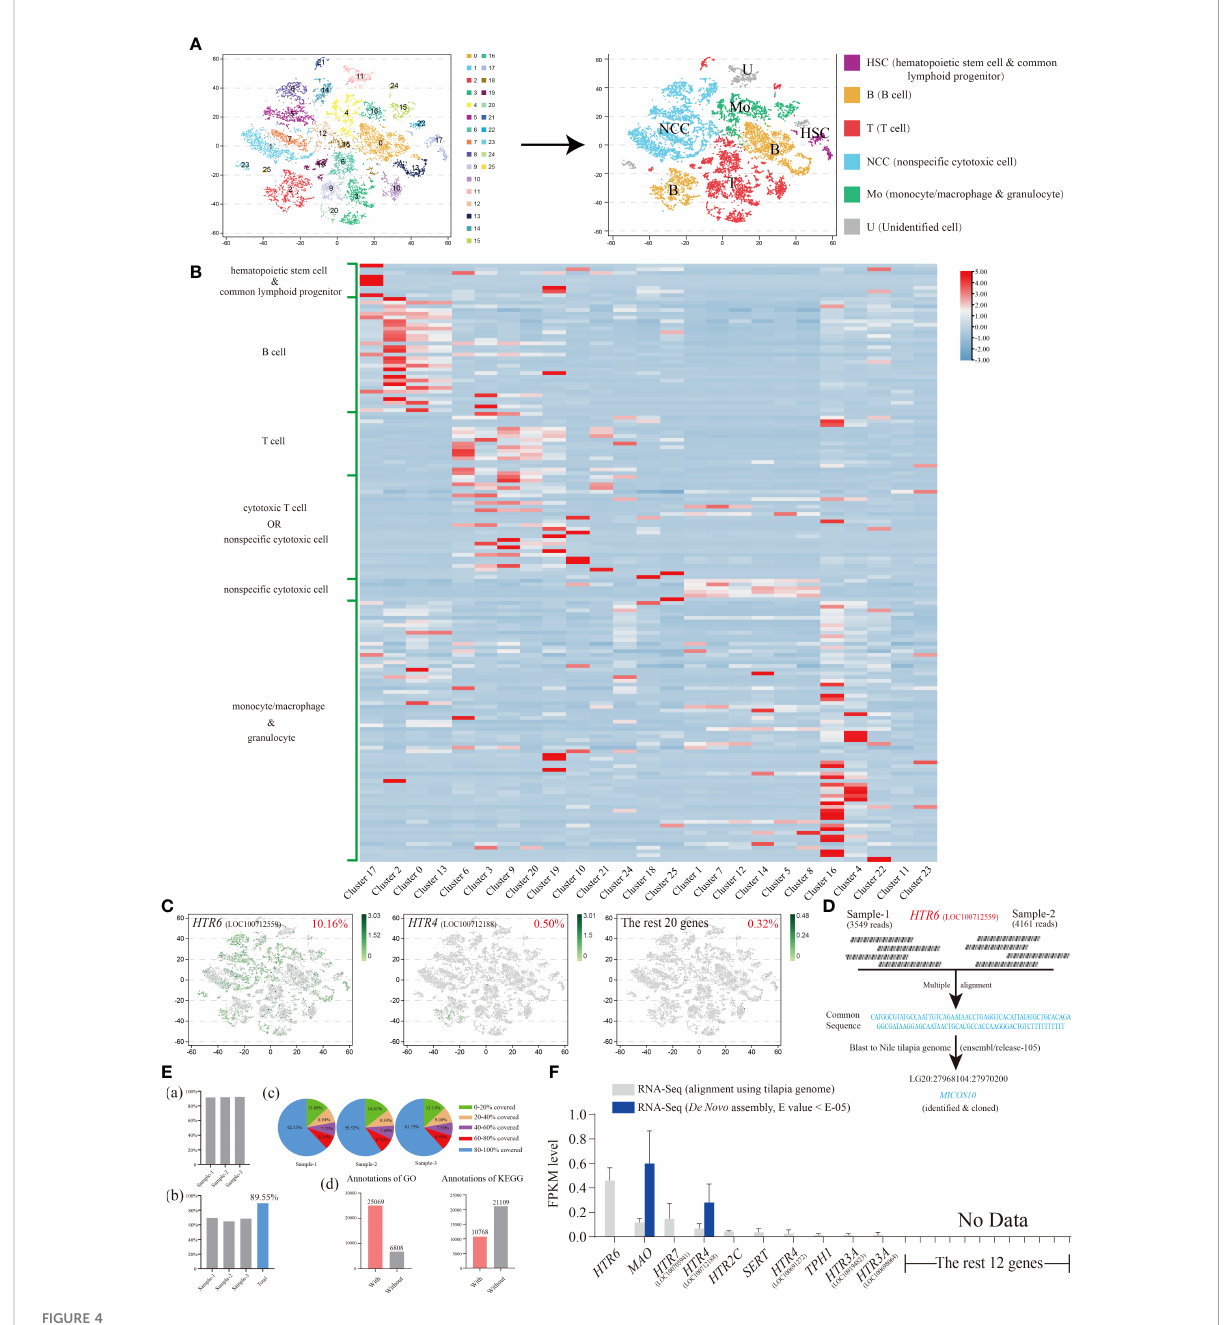
FIGURE 4 (A) The visualization of Nile tilapia HKL population via tSNE nonlinear clustering. Left, original classi fi cation of Nile tilapia HKL population. Right, identi fi cation of six cell subpopulations based on marker genes. (B) Heat map of the expression of different types of cell marker genes among each cluster. See Table S3 for the details of marker genes. (C) The tSNE results of the top two genes, HTR6 and HTR4 , as well as the remaining 20 genes. The number at the top right of the fi gure indicates the proportion of positive cells. Each dot in the fi gure represents a cell. See Table S4 for the details of marker genes. (D) Diagram of analysis process of HTR6 sequence from scRNA-Seq. (E) Basic information of Nile tilapia HKL RNA-Seq aligned via reference genome. Proportion of genes mapped to the reference genome (A) . Proportion of reference genome genes sequenced in three samples and their union (B) . Distribution of genes ’ coverage of each sample (C) . Number of unigenes annotated via GO and KEGG (D) . (F) Expression level of On-TPH1 , On-TPH2 , On-SERT , On-MAO , and On-HTRs in Nile tilapia HKL RNA-Seq aligned via reference genome or de novo assembled. See Table S5 for the expression details of candidate